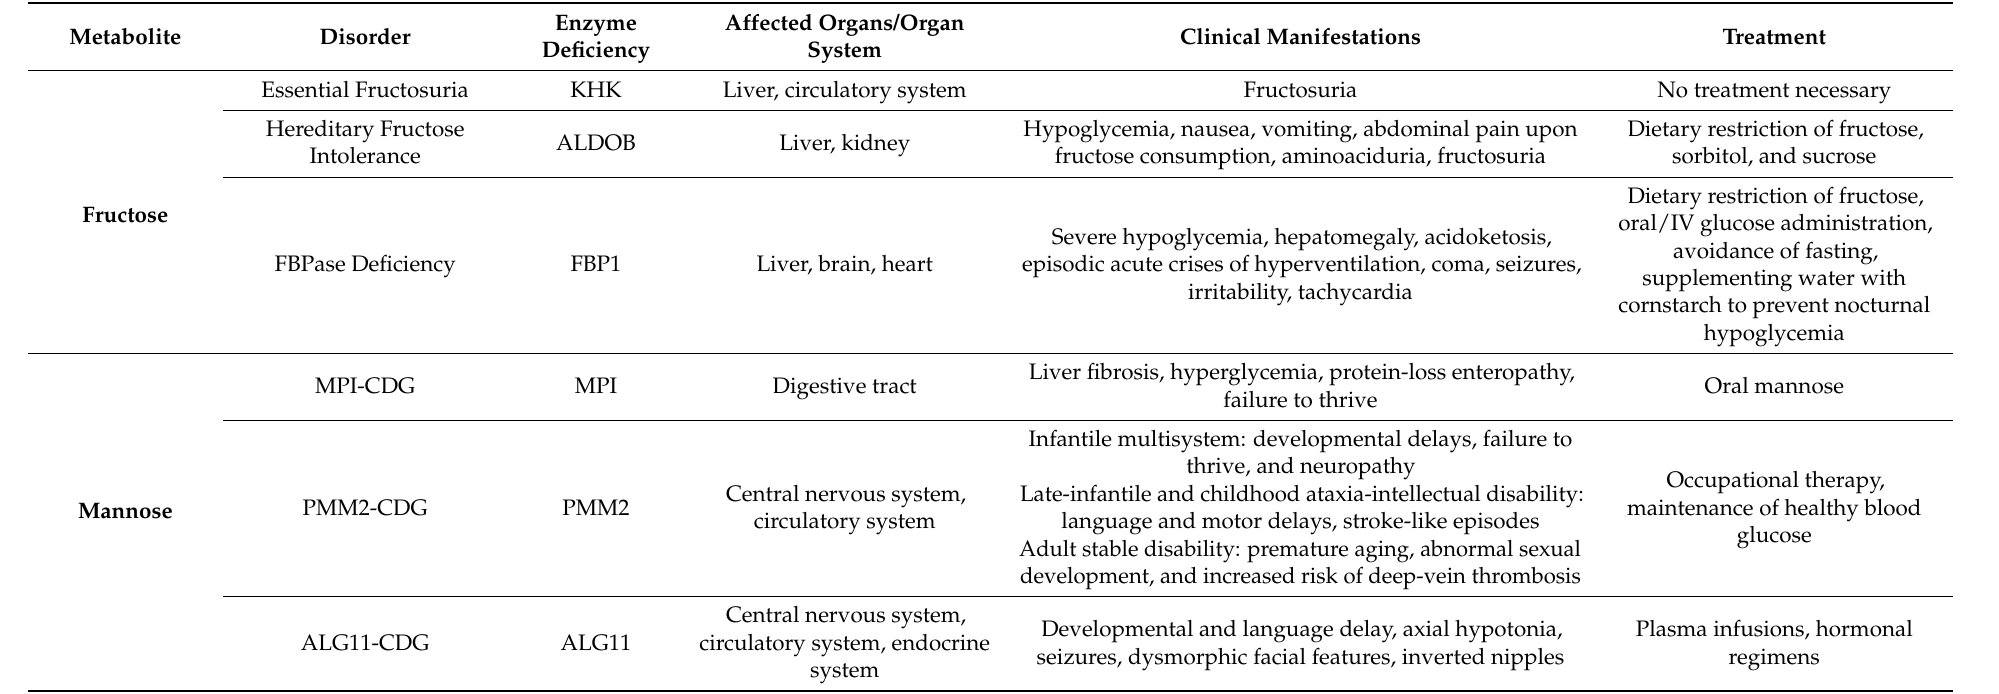
Table 1. Clinical manifestation and treatment of inborn errors of fructose and mannose